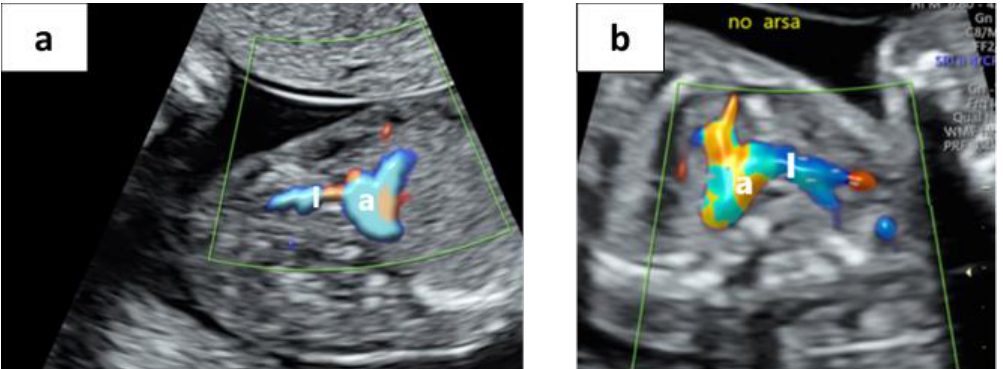
Figure 2. The “No ARSA” sign. The brachiocephalic artery (I) arises from the aortic arch and bifurcates into the RCA (right carotid artery), which courses as a continuum of the brachiocephalic artery cranially and the RSA (right subclavian artery) coursing posterolateral ( a ) at 14.3 weeks and ( b ) at 21.2 weeks.